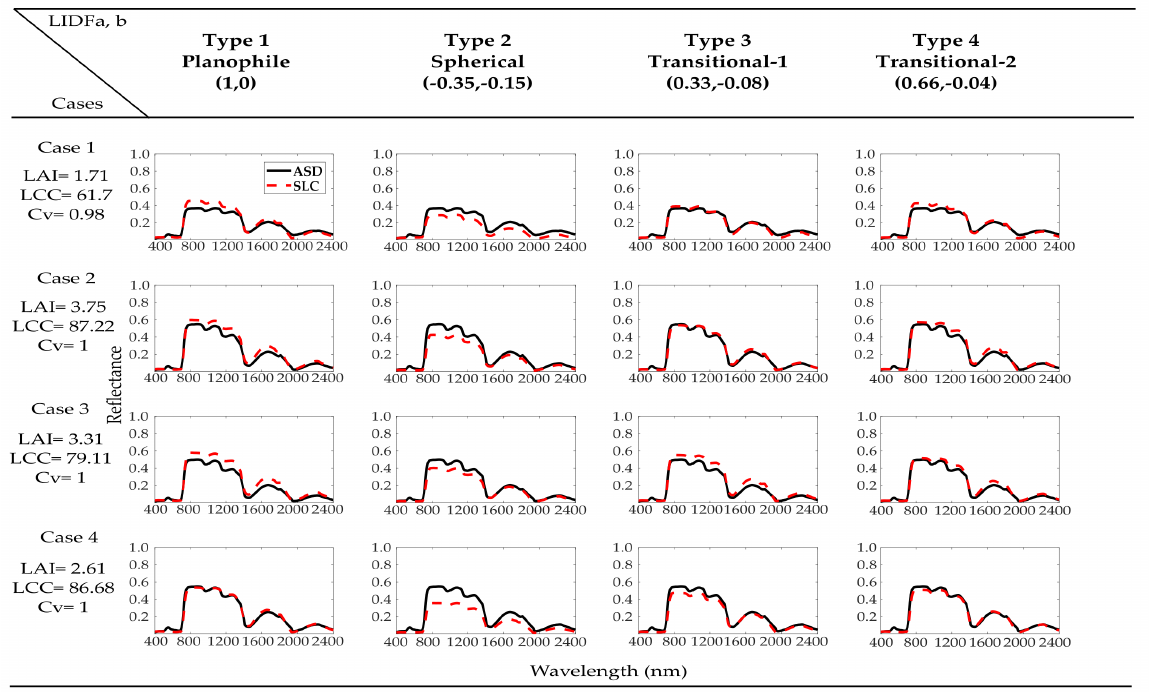
Figure 3. Comparison between measured (black) and simulated (red) spectra for four types of leaf inclination distribution functions (LIDFs) and four selected potato plots (cases) to identify the LIDF type that best represents